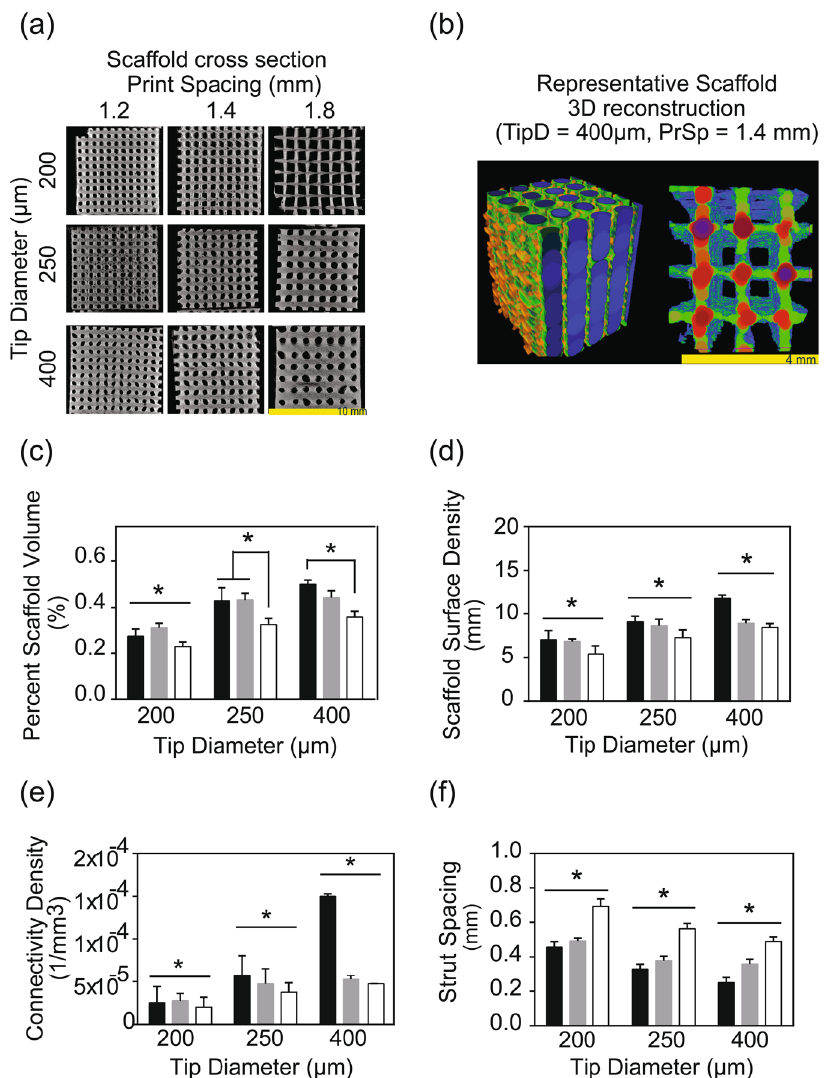
Fig. 7 a Microcomputed tomography cross-sections of the 75% ß- TCP + CMC scaffolds printed with varying tip diameters and strut spacing. b Representative 3D reconstruction of the volume of interest (VOI) of a scaffold with TipD 200 µm, PrSp 1.4 mm, and VOI = 4.05 × 4.05 × 4.05 mm 3 ). In the 3D reconstruction, StSp and StTh are displayed in a color map based on sphere fi lling, speci fi cally, Left: printed pore size distribution where the pore size is uniform and Right: strut thickness uniformity, except for the intersections of perpendicular struts. c The percent scaffold volume (SV/TV) increased as TipD increased and decreased as PrSp increased. The 200 µm TipD group had signi fi cantly (* p < 0.001) lower SV/TV compared to the other two tip diameter groups tested. Within each TipD group, the SV/TV decreased as the PrSp increased; this trend was signi fi cantly (* p < 0.001) different within the scaffolds in the 1.8 mm PrSp group, printed exhibited signi fi cantly ( p < 0.007) higher connectivity density (7.8 × 10 − 5 ± 3.7 × 10 − 5 ) compared to pertinent